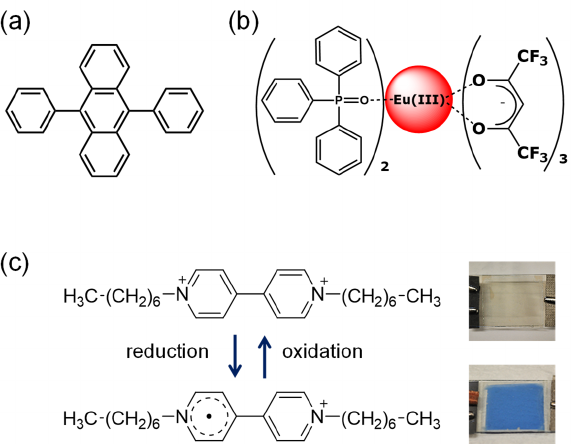
Figure 1. Chemical structure of ( a ) DPA, ( b ) Eu(hfa) 3 (TPPO) 2 (hfa; hexafluoroacetylacetone), and ( c ) HV 2+ .